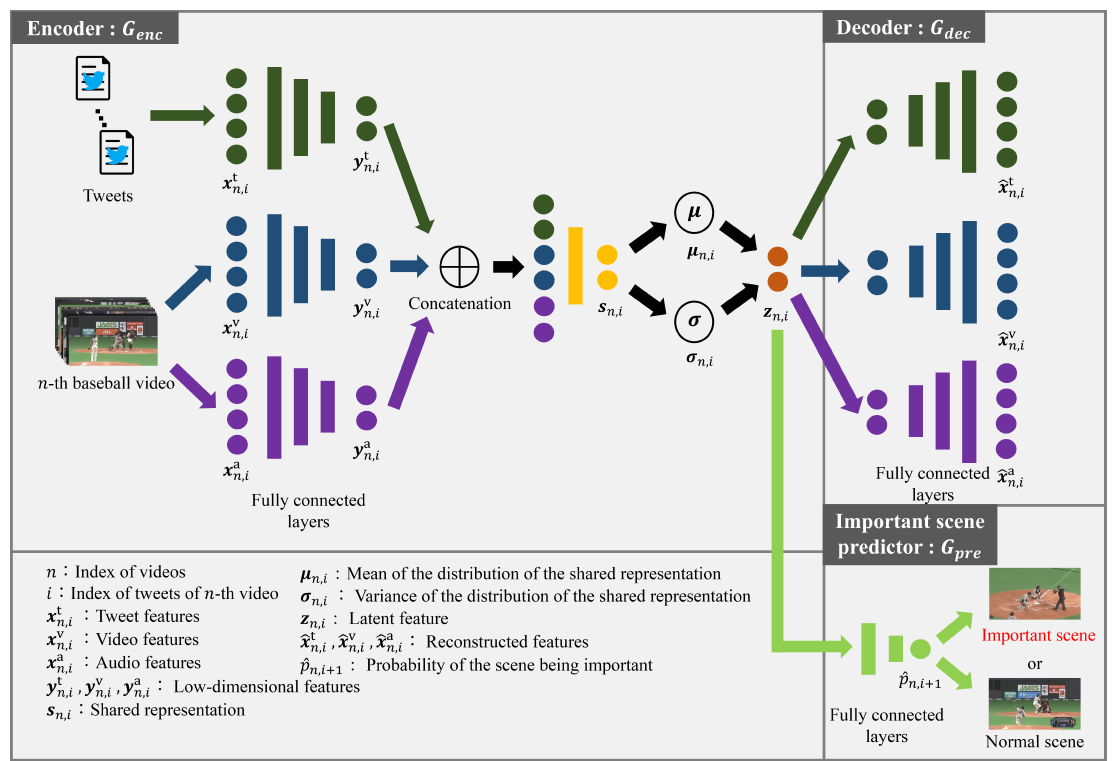
Figure 1. Overview of Tl-LVM. The encoder extracted latent features from features of tweets and baseball videos. By the decoder, original features were reconstructed from latent features.